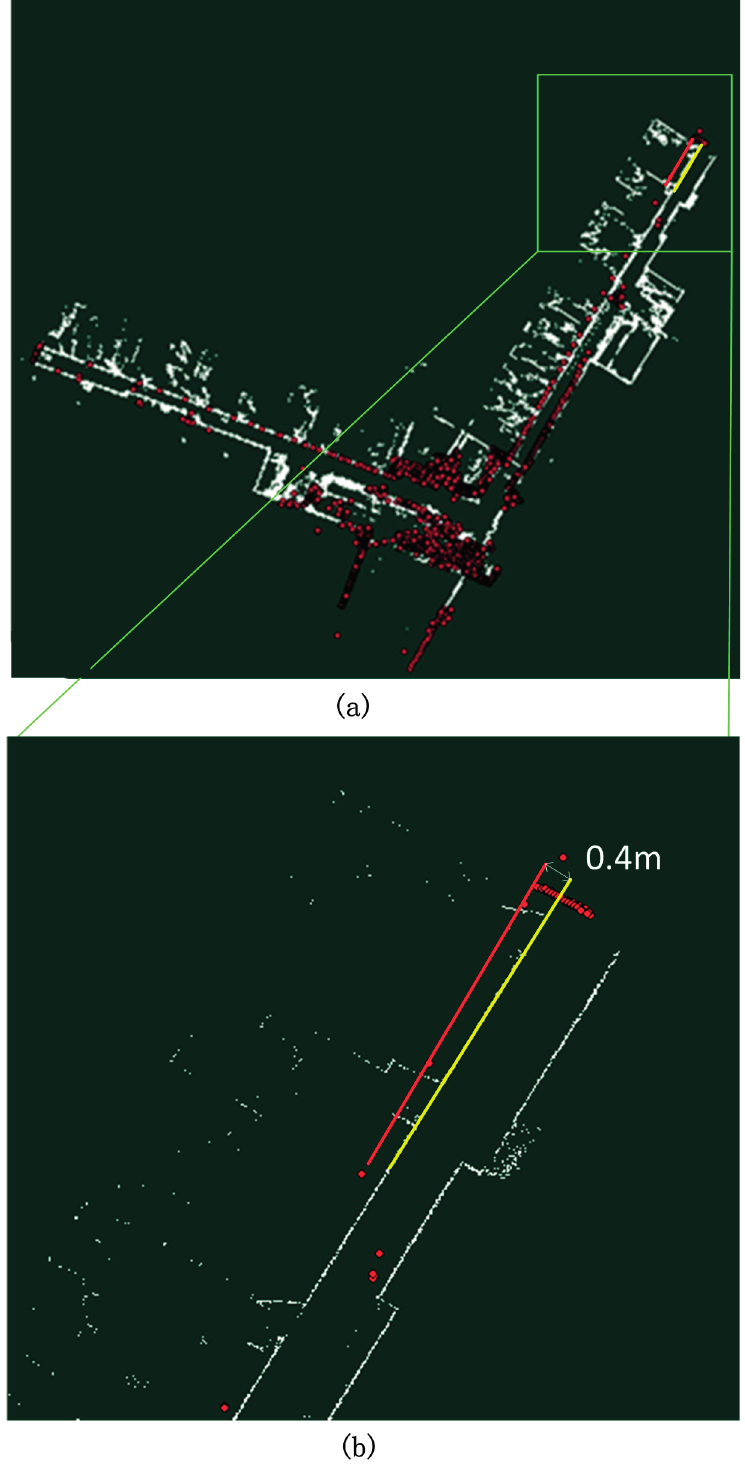
Figure 4. ( a ) The NAVIS mapping result of the FGI corridor compared with TLS; ( b ) map error